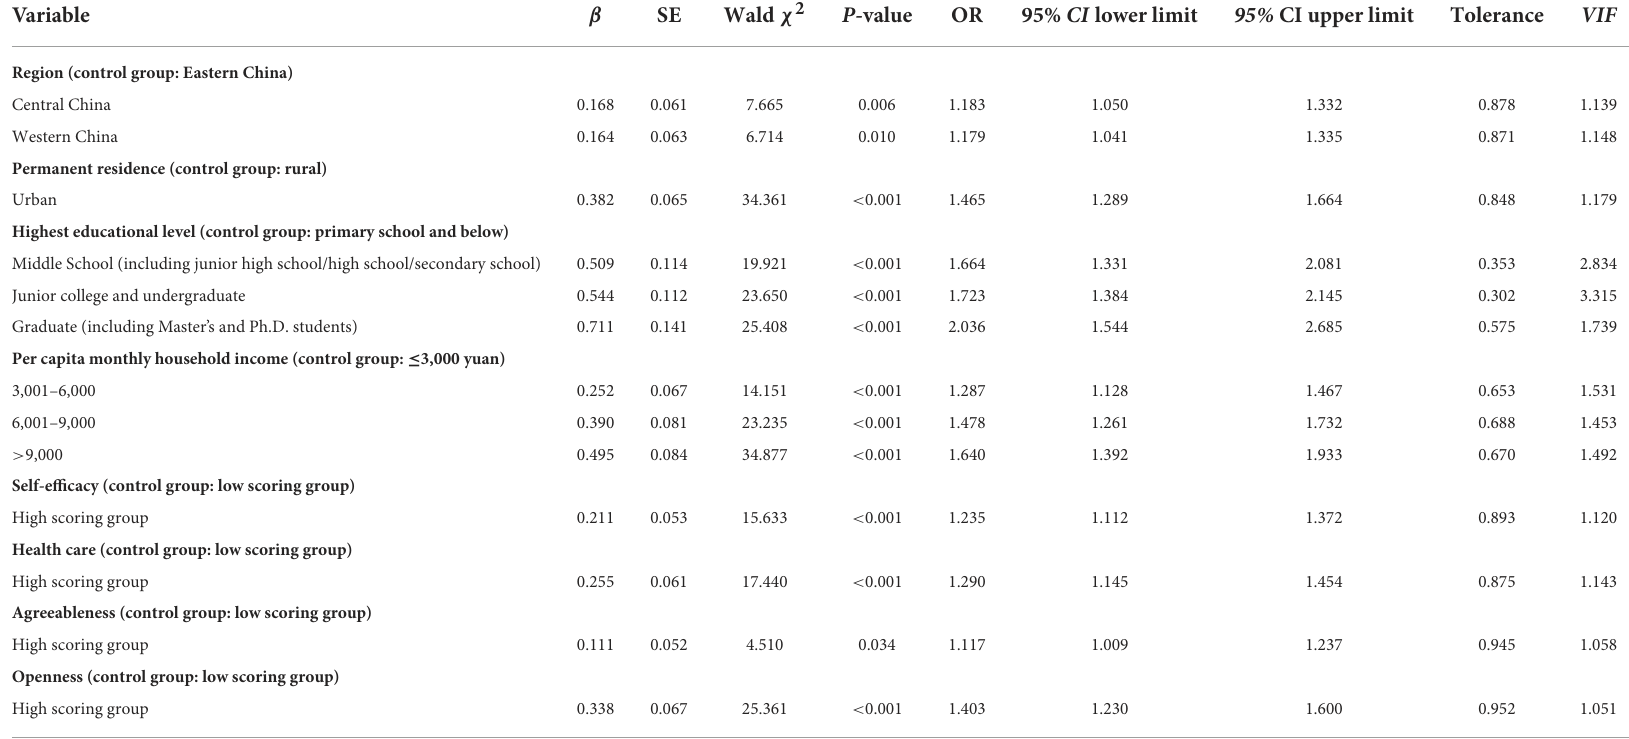
TABLE 3 Multifactorial stepwise logistic regression analysis of home first aid kit preparation